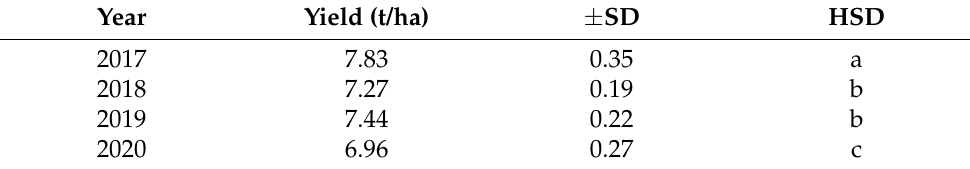
Table 4. Results of descriptive statistics—vegetation indices for the period